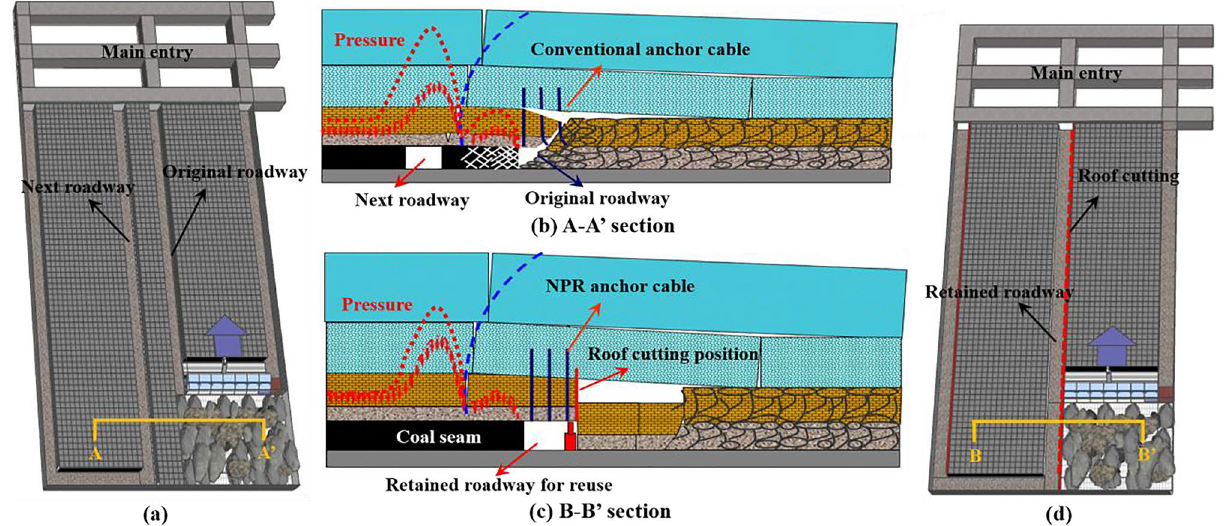
Figure 1. Principle of the conventional longwall mining system and the ARFRC